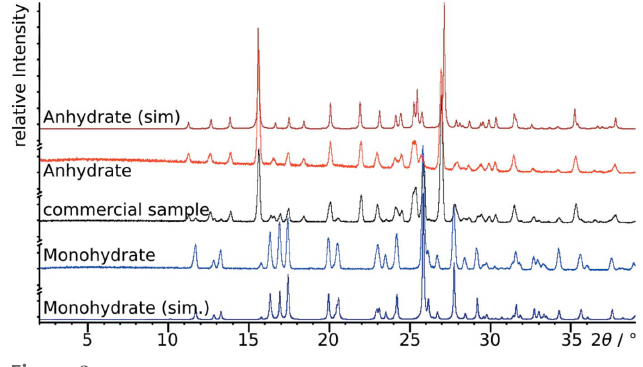
Figure 3 X-ray powder diagrams of (from top to bottom) the known anhydrous title compound (simulated, dark red), the vacuum-dried title compound (red), the commercial sample (black), the title compound (blue) and the pattern simulated from the title compound’s single-crystal structure (dark blue).